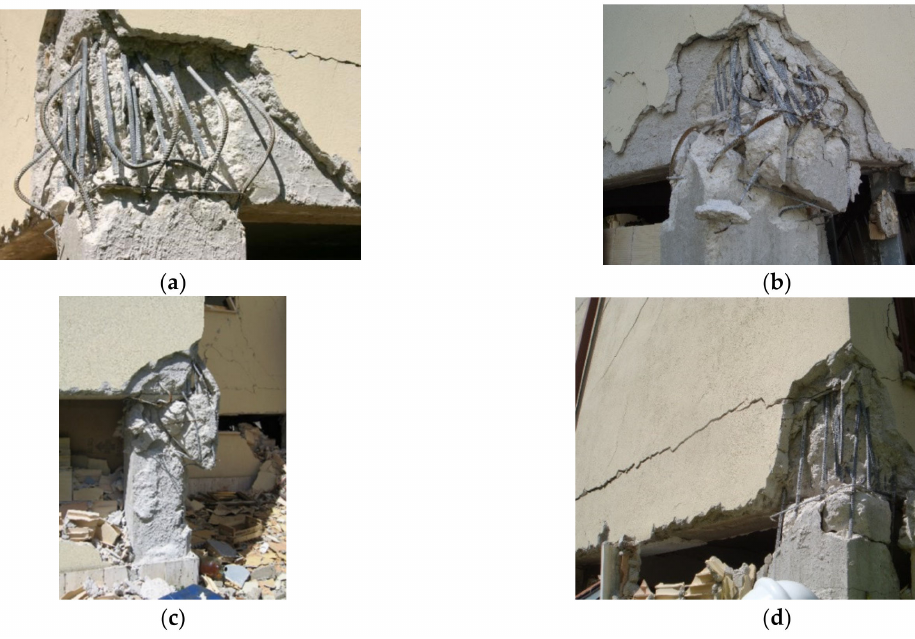
Figure 7. Damage type 4—example of post-earthquake damage in beam-column RC joints: ( a ) absence of transverse reinforcement; ( b ) bond-split of the reinforcement and inadequate reinforcement anchorage; ( c ) shear failure of the column due to insufficient transverse reinforcement; and ( d ) poor detailing and design of the beam-column joints.